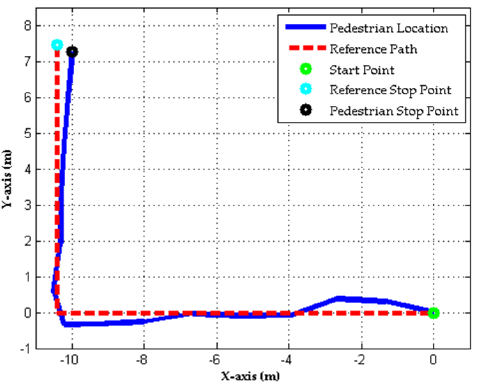
Figure 17. Estimated walking trajectory generated from the proposed indoor positioning algorithm.